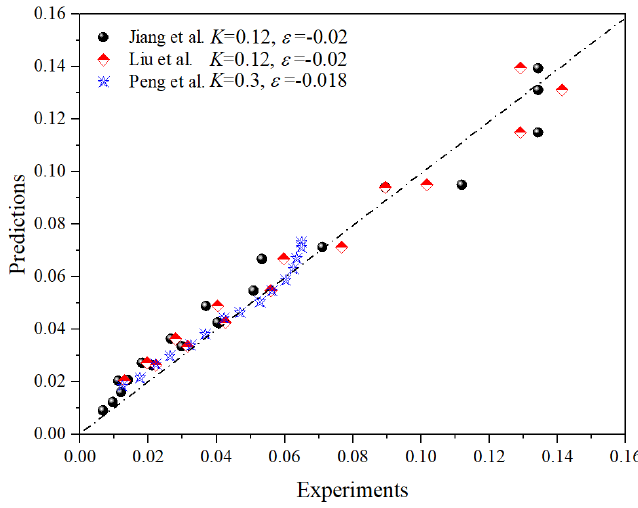
Figure 14. Comparisons of v a in [31–33] to their predictive value based on Equation (9), Φ = 1.0.